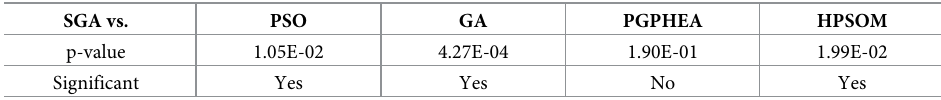
Table 5. Wilcoxon signed-rank-test ( p � 0.05) for average error in continuous problems of Set A. SGA